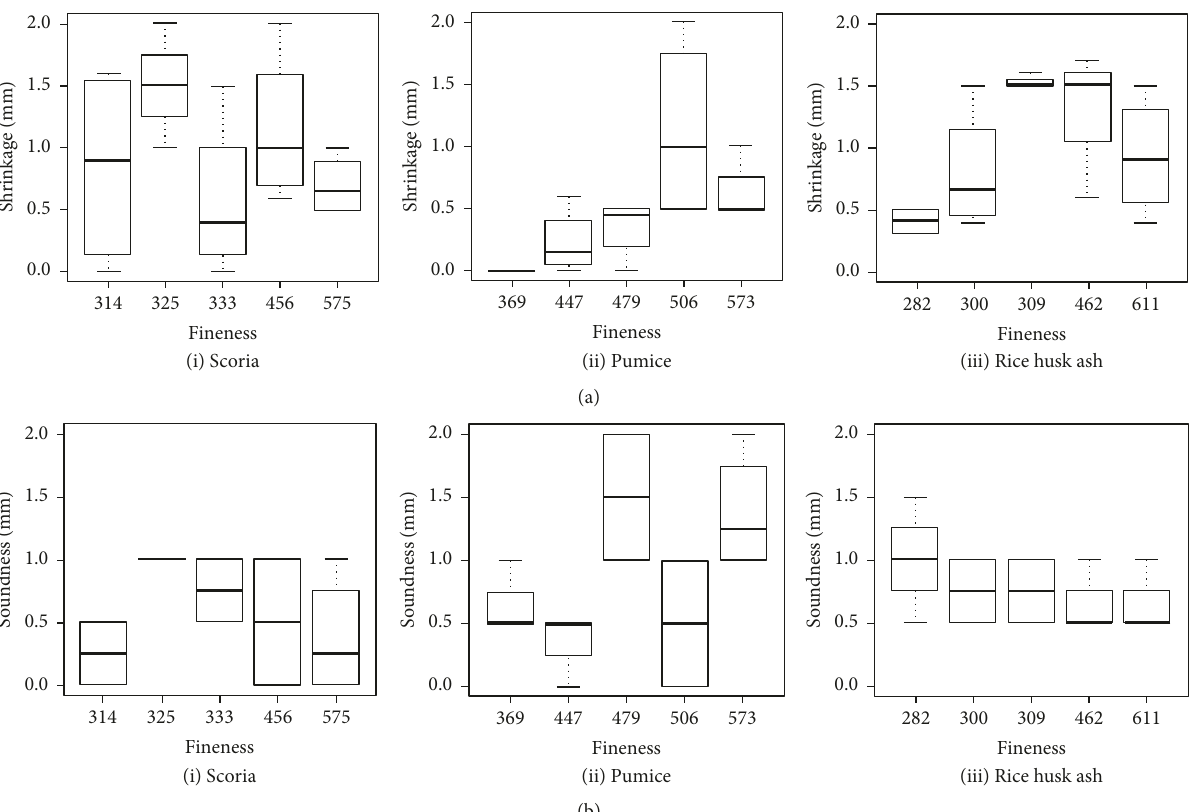
Figure 7: Effect of fineness on (a) shrinkage and (b)